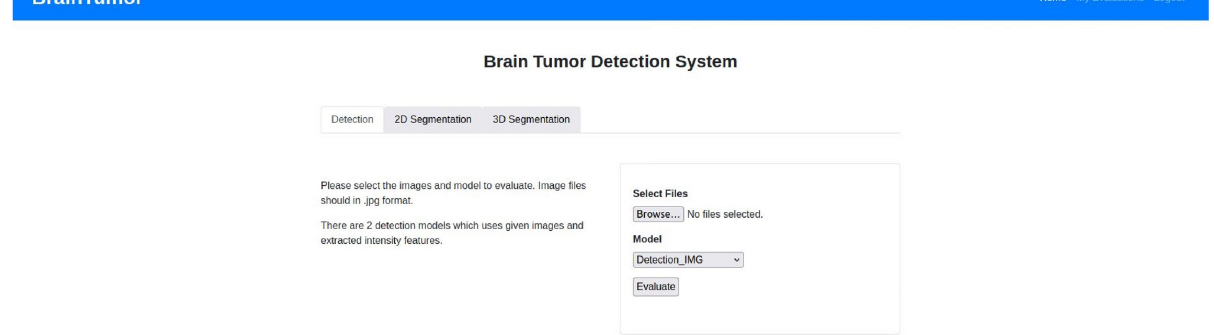
Fig 12. Tumor detection page.